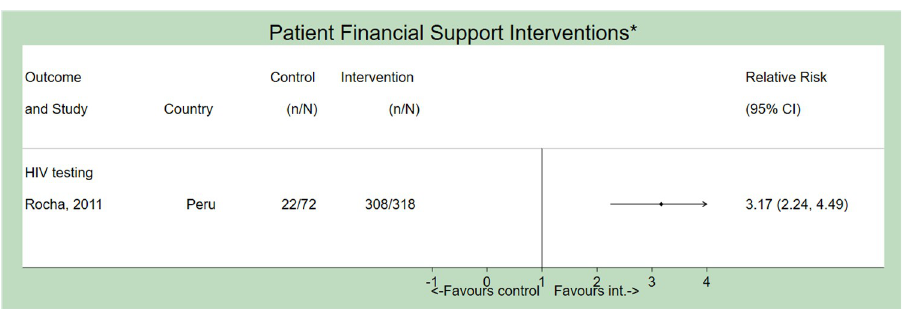
Fig 7. Forest plot (not pooled) depicting the effect of patient financial support interventions on all outcomes. � All studies implemented concurrent interventions and/or SOC strategies. Only the first author of each study is listed. ATT = Anti-tuberculosis